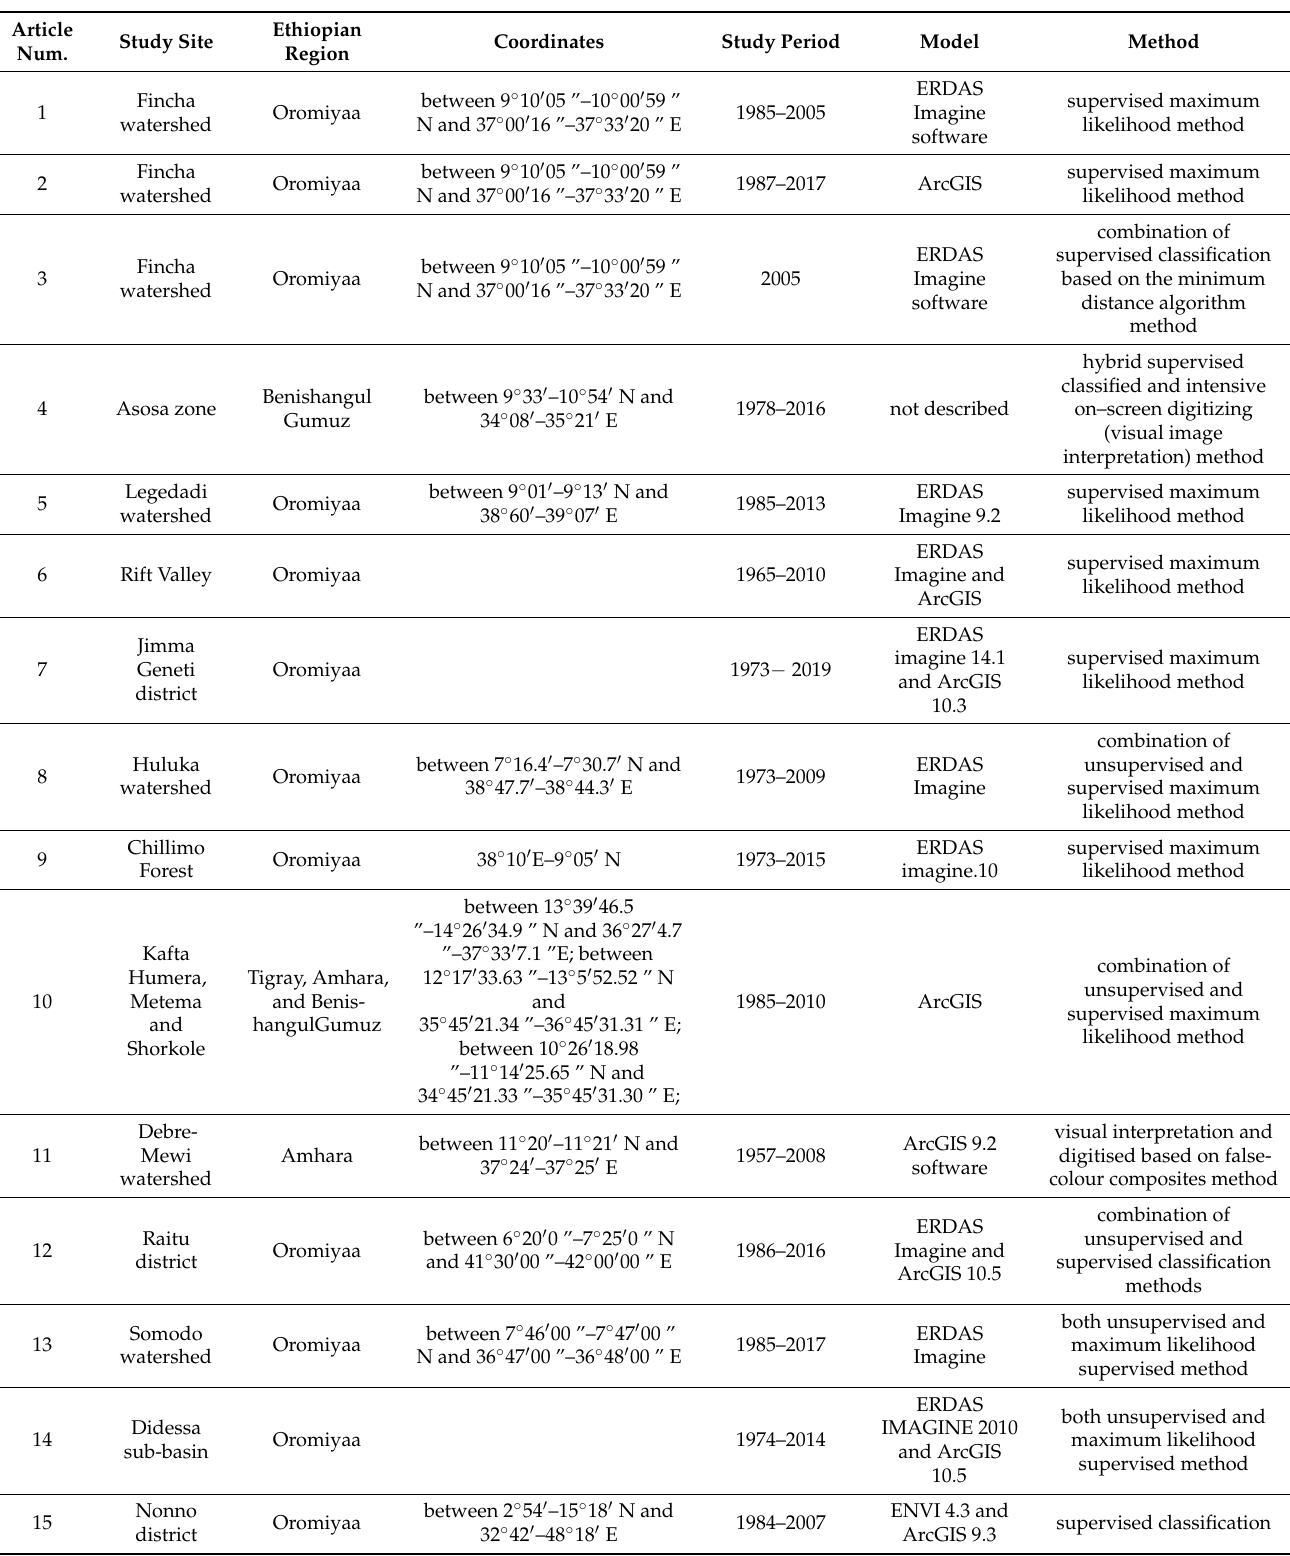
Table 2. Characteristics of the study area for the selected case studies in